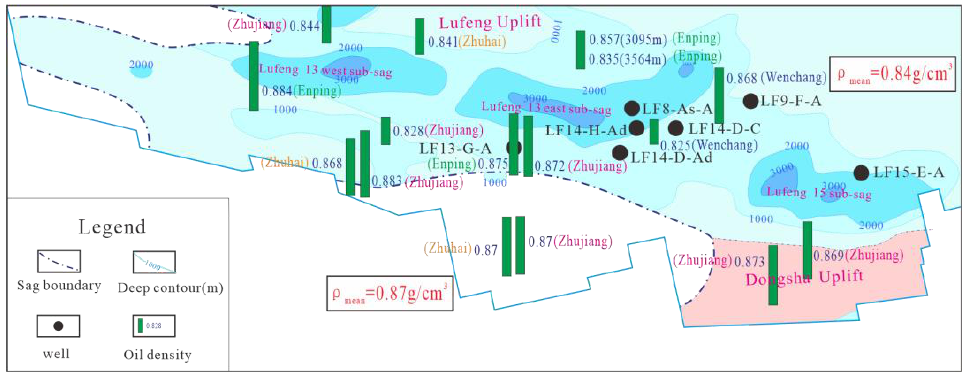
Figure 5. Distribution characteristics of crude oil density in the southern Lufeng sag.